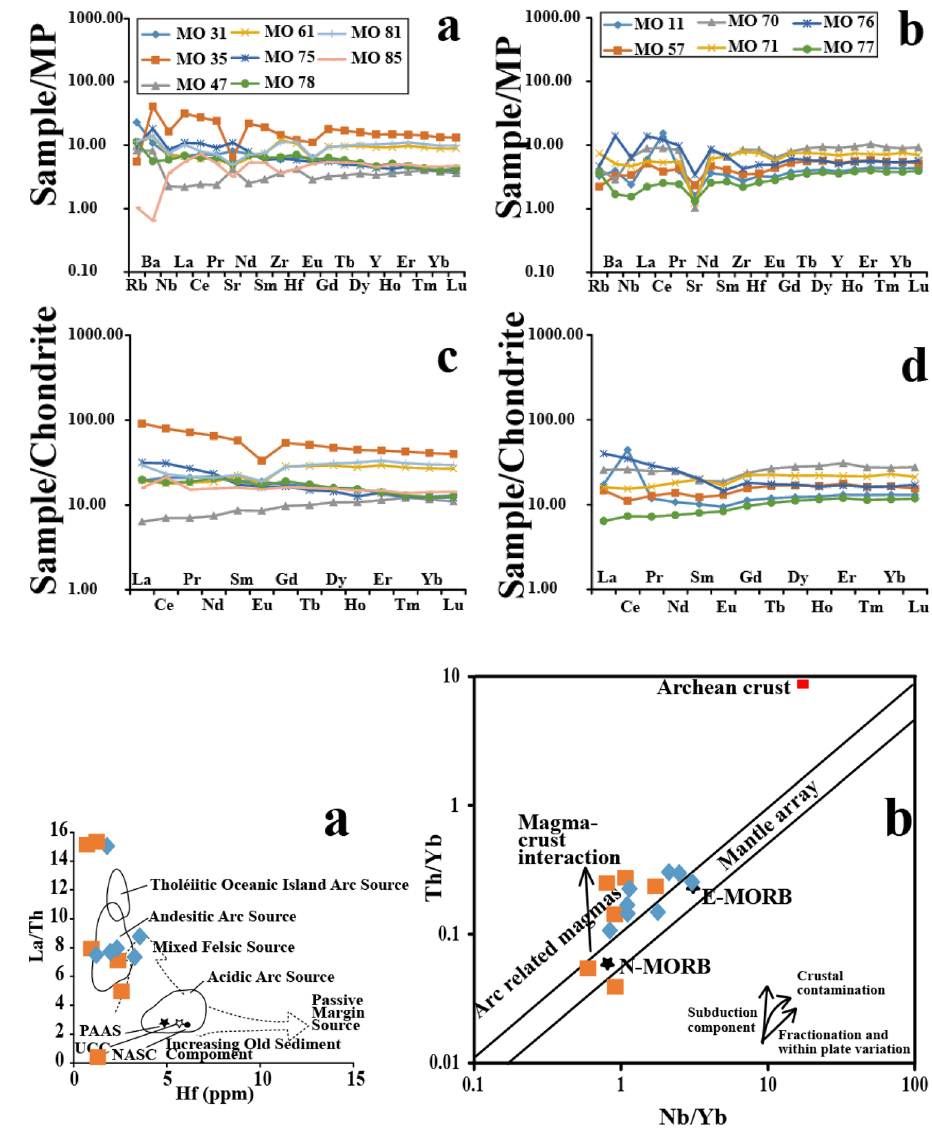
Fig. 12 a Chondrite-normal- ized REE patterns of FGM after [73], b Chondrite-normalized REE patterns of the FGM after [73], c Primitive mantle normal- ized multi-element spider diagram for the studied CGM after [72], d Primitive mantle normalized multi-element spider diagram for the studied CCM [72]. Symbols are the same as in Fig. 5